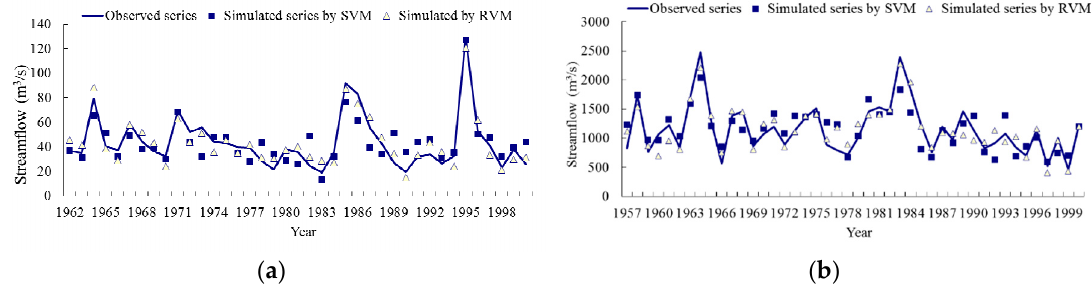
Figure 3. Observed and simulated streamflow data in the Dahuofang Reservoir ( a ) and Danjiangkou Reservoir ( b ) during the training period by the RVM and SVM model.